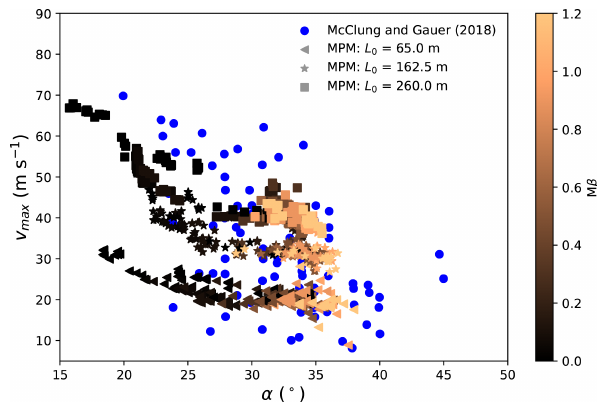
Figure 9. Evolution of the maximum velocity with α for different horizontal lengths L 0 .